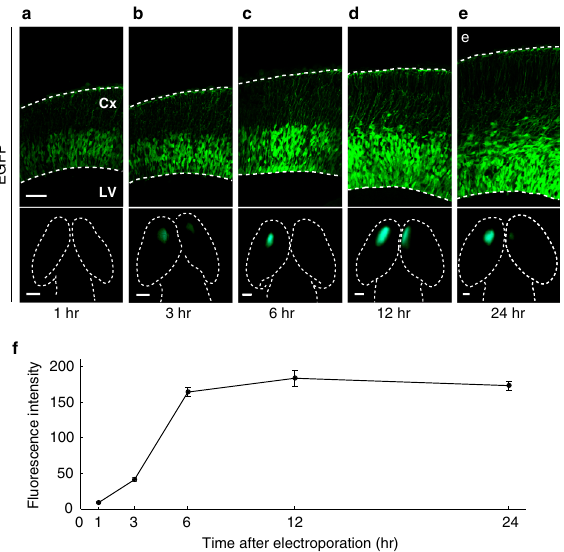
Figure 1. Immediate EGFP expression after mRNA electroporation. The EGFP mRNA containing 5moU was injected into the lateral ventricle (LV) of the E13.5 mouse brain, followed by electroporation. ( a – e ) Coronal sections of the cerebral cortex (Cx) (upper panel) and dorsal views of the brain (lower panel), one to 24 h after electroporation. Many EGFP-positive cells were observed in the ventricular zone. The EGFP fluorescence 1 h after electroporation was too feeble to detect under the fluorescent stereomicroscope. Scale bars: 50 µm (upper panel), 500 µm (lower panel). ( f ) Fluorescence intensity of EGFP-positive areas, one to 24 h after electroporation. Data are presented as mean ± s.e.m. n = 5 electroporated brains.